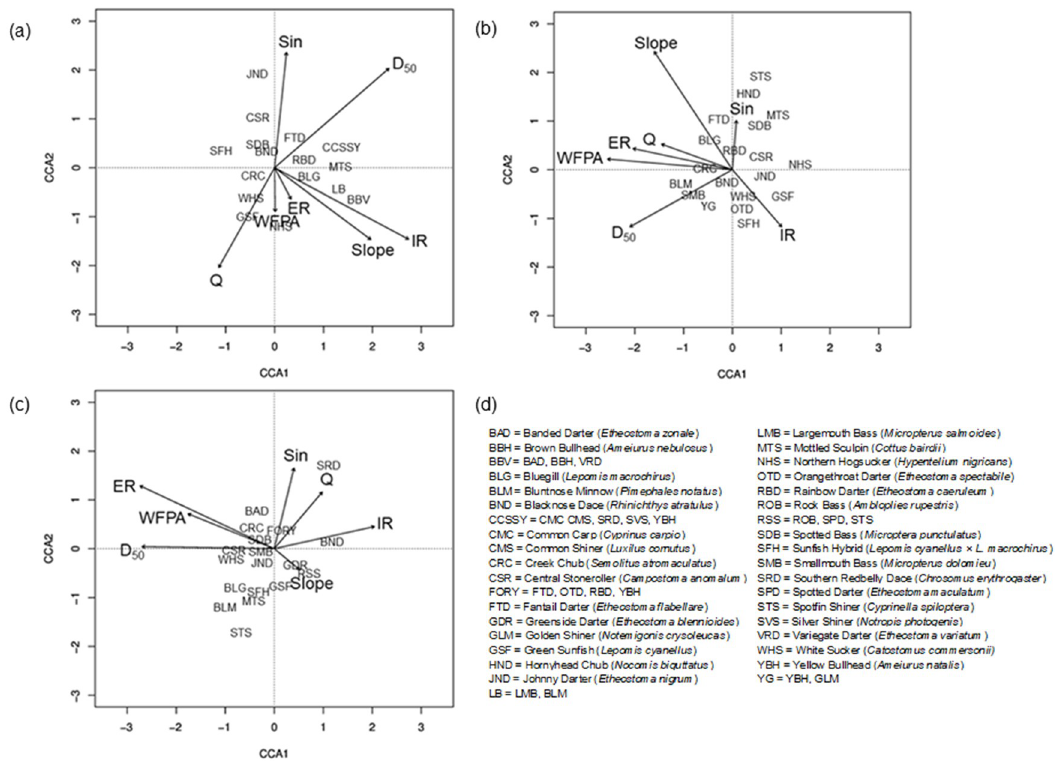
Fig 5. Ordination biplots from canonical correspondence analysis by year. Ordination biplots based on canonical correspondence analysis of seven hydrogeomorphic variables that minimize variance inflation factors and the relative abundance of fish species in (a) 2011, (b) 2012, and (c) 2013. Panel (d) provides key to species abbreviations.